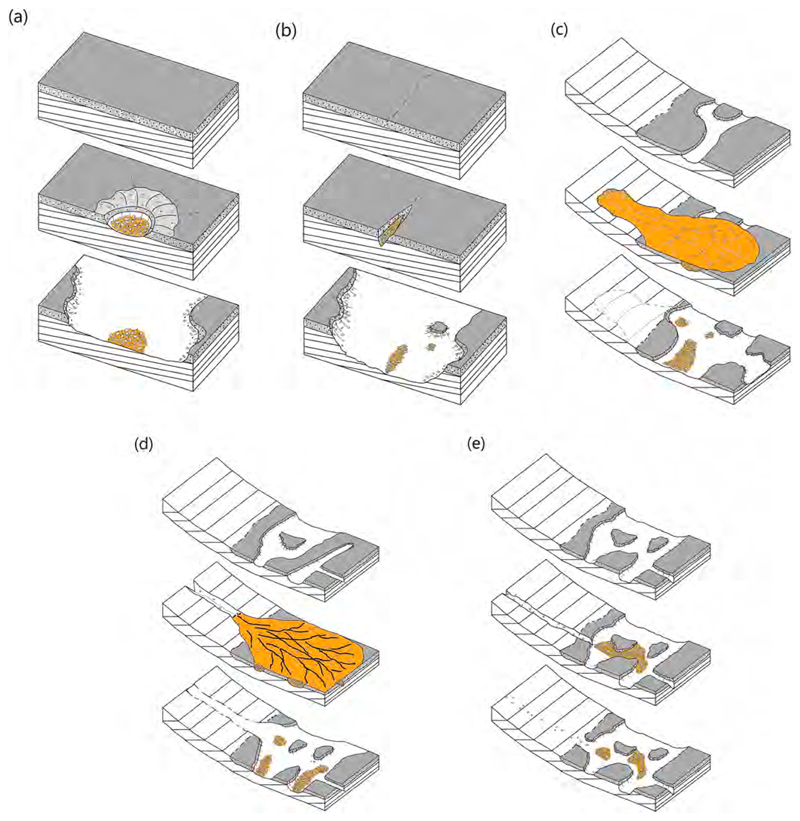
Possible scenarios for formation of the heterolithic units. Each panel shows three time steps. The gray stippled top layer is the Stimson formation, the white bedded unit is the Murray, and the orange records the heterolithic unit. (a) Impact penetrates through the Stimson formation into the Murray formation, creating a crater whose walls erosionally retreat through time. (b) Incision into a resistant Stimson cap rock (either by wind or water) that creates buttes and sheds Stimson and Murray blocks into a narrow valley. Further erosional retreat leaves isolated patches. Alternately, buttes decay in place to create the heterolithic units. Sediments are protected from weathering in the original location of the incision, or boulders shed from the mesas are collected in certain areas that are sheltered from wind erosion. (c) Mass transport of debris, either dry or by glacial processes, followed by extensive erosion that obscures the original source region. (d) Large-scale fluvial or debris flow fan deposits followed by erosion. (e) Localized fluvial or debris flow followed by erosion.